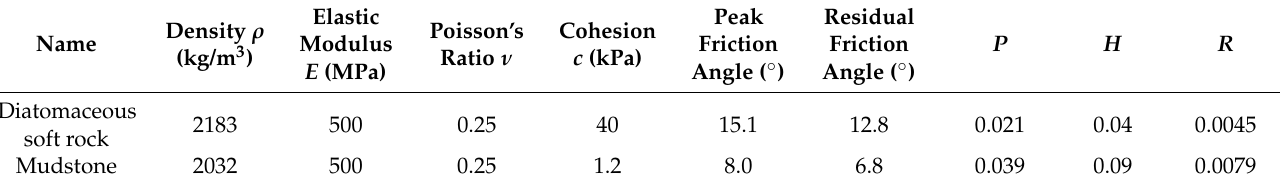
Figure 4. Determination of parameters for hump curve function. Table 1. Parameters and values for numerical